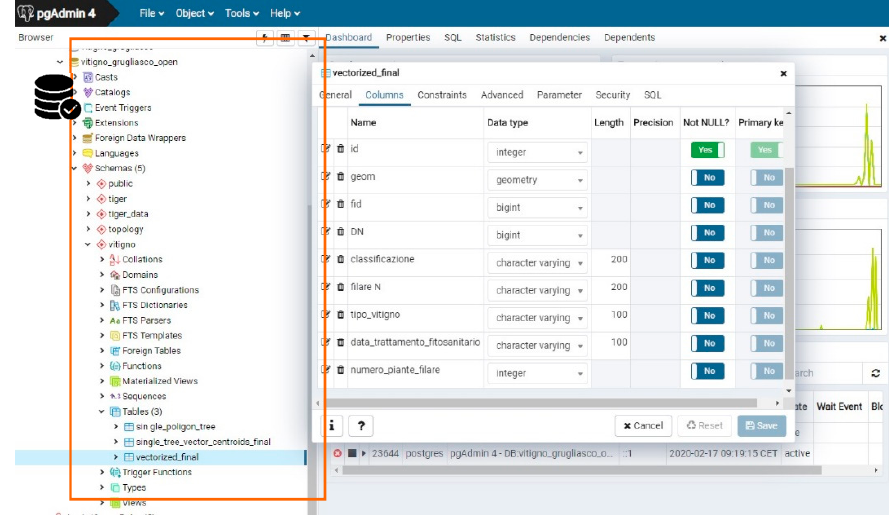
Figure 12. Database tables creation in PostgreSQL (in the PgAdmin interface).